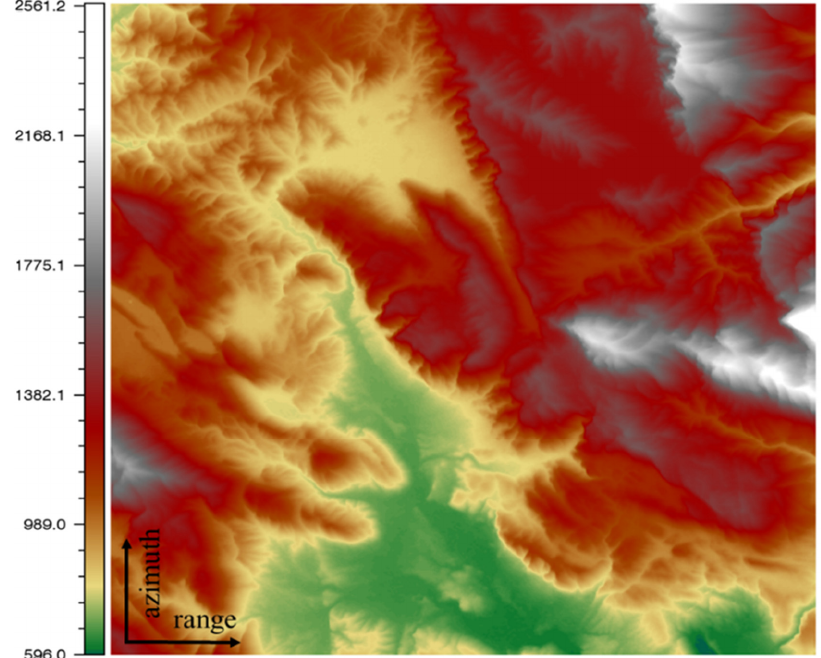
Figure 7. Elevation (m) of the DEM: representation in the image space. The range direction is from left to right; the azimuth direction is from bottom to top.